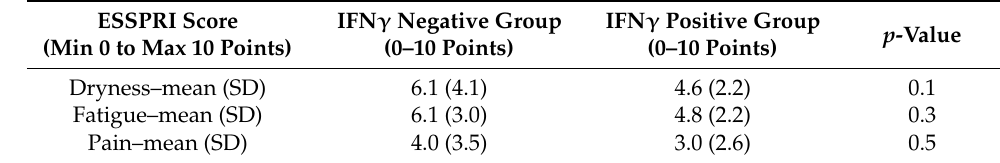
Table 3. The point value of individual ESSPRI domains in pSS patients with positive and negative IFN γ concentrations in peripheral